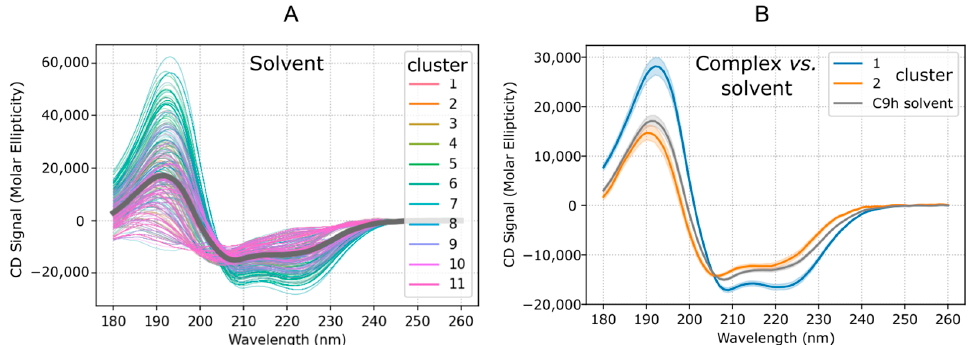
Figure 3. Predicted CD of C9h peptide. Data of molar ellipticity versus wavelength predicted from the MD simulation: ( A ) Spectra predicted for 702 frames periodically taken from the MD trajectory at 300 K (1 step out of 20). Color shades are attributed to the clusters as assigned in Figure 1A. The dark curve corresponds to the average over all conformations. ( B ) Average CD spectrum for C9h in solvent and simulations of C9h in interaction with PP2A starting from different positions. Clusters 1 and 2 correspond to the clusters described in Section 3.3.